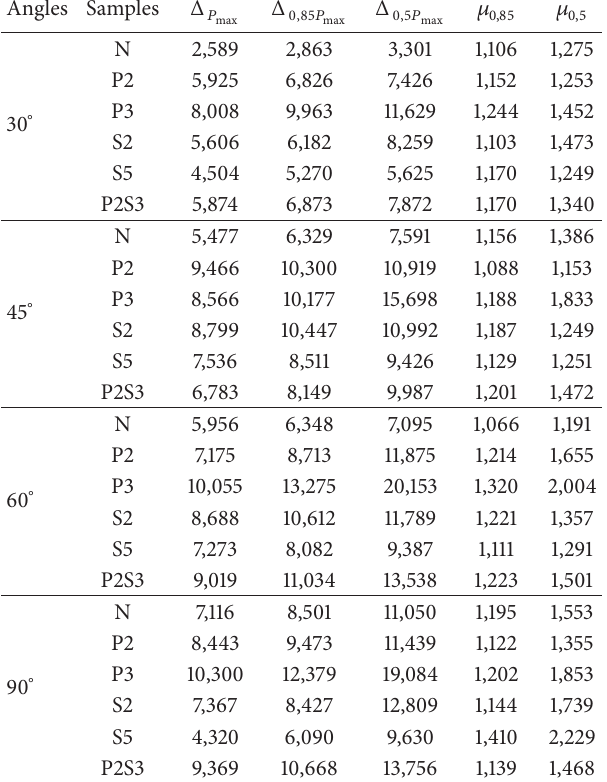
Table 7: The shear stress obtained according to the wall types.